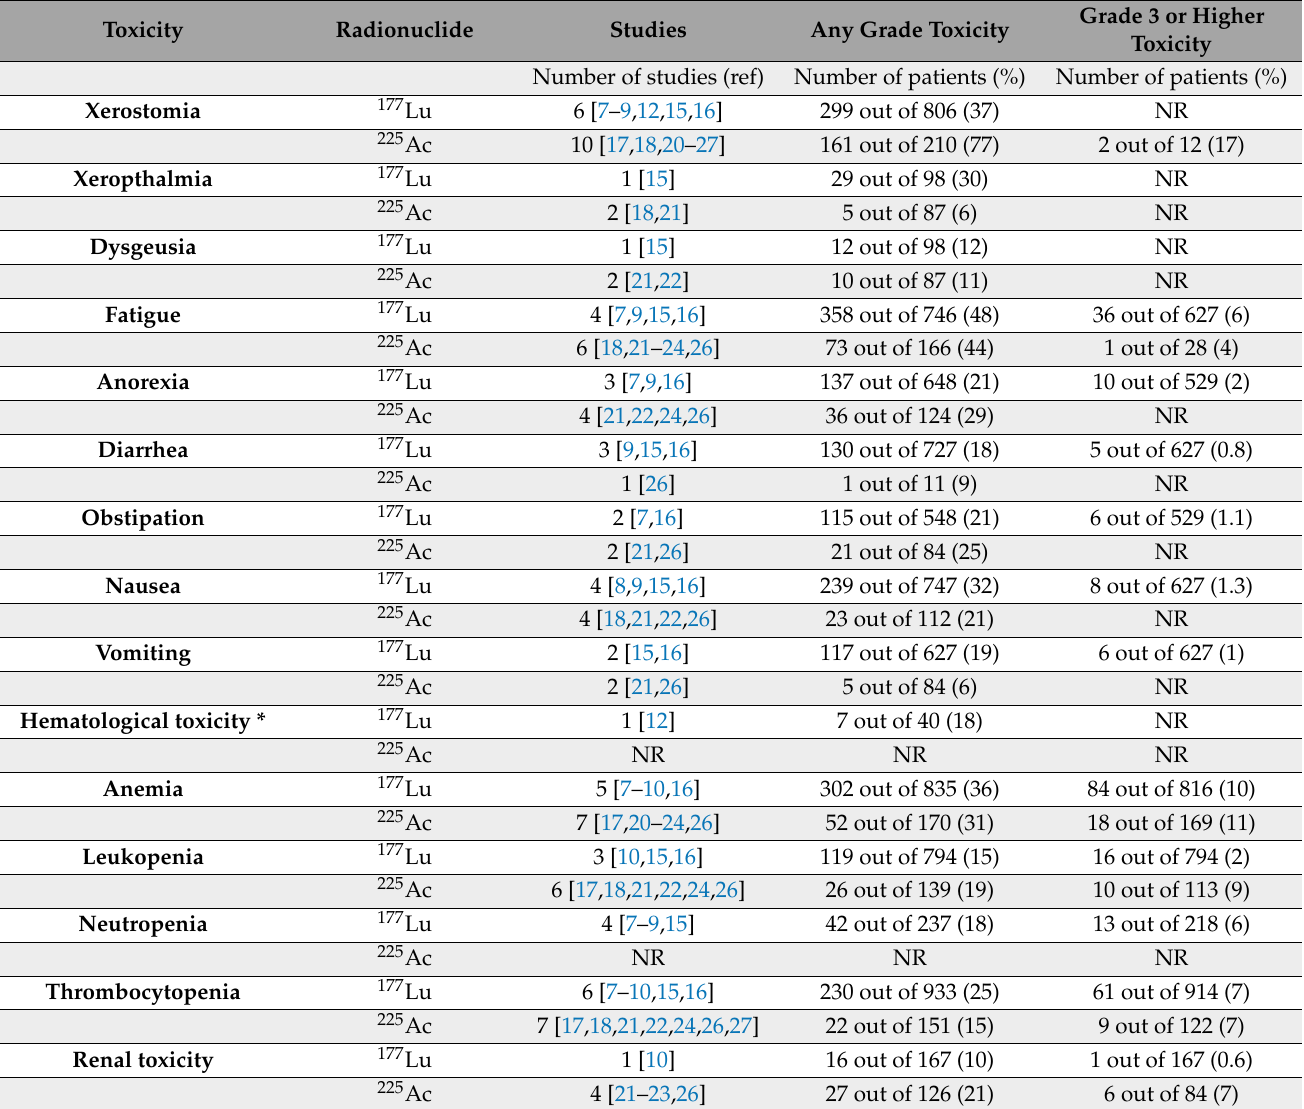
Table 2. Frequencies of toxicities with 177 Lu-PSMA and 225 Ac-PSMA RNT according to Common Terminology Criteria for Adverse Events (CTCAE) version